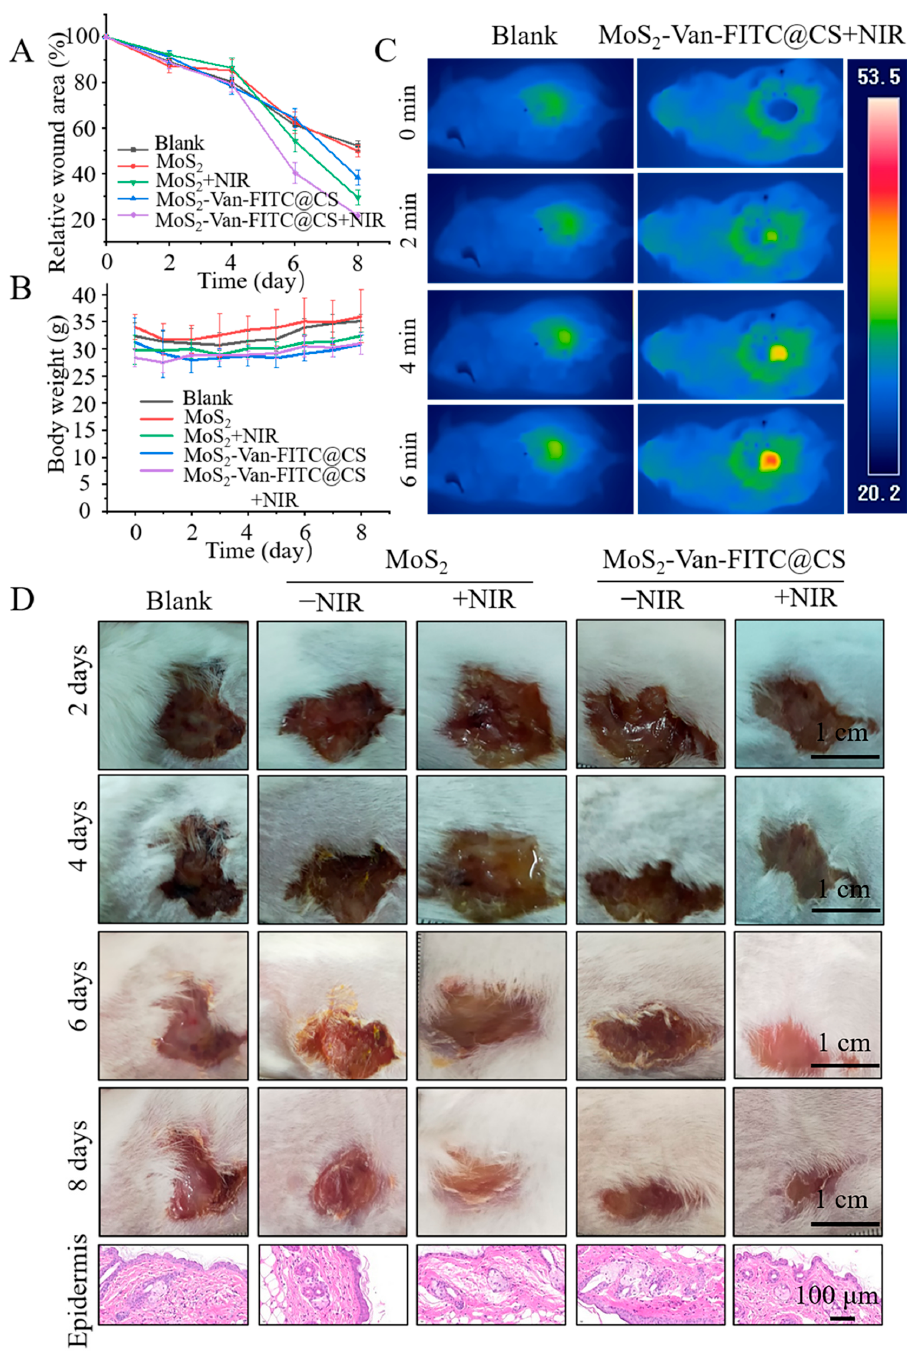
Figure 8. In vivo wound healing analysis. ( A ) The relative wound area curve shows the MoS 2 -Van-FITC@CS hydrogel had a significant positive effect on wound healing. ( B ) The body weights of different groups after treatment. ( C ) The thermal imaging of mice after treatment. The cells underwent NIR irradiation at 808 nm (1.5 W/cm 2 , 6 min). ( D ) The photographs of wounds were taken every 2 days after treatment. MoS 2 -Van-FITC@CS hydrogel + NIR (100 µg/mL), MoS 2 NPs (100 µg/mL), MoS 2 NPs + NIR (100 µg/mL) and MoS 2 -Van-FITC@CS hydrogel served as control groups. PBS + NIR served as a blank group. The cells underwent NIR irradiation at 808 nm (1.5 W/cm 2 , 6 min). Scale bar = 1 cm. Results shown are mean ± SD, n =